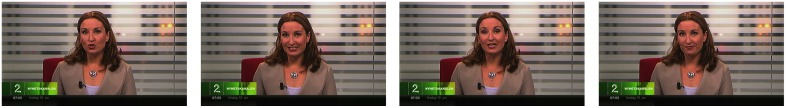
The four screenshots represent the timeline of the long-running speech sequence.